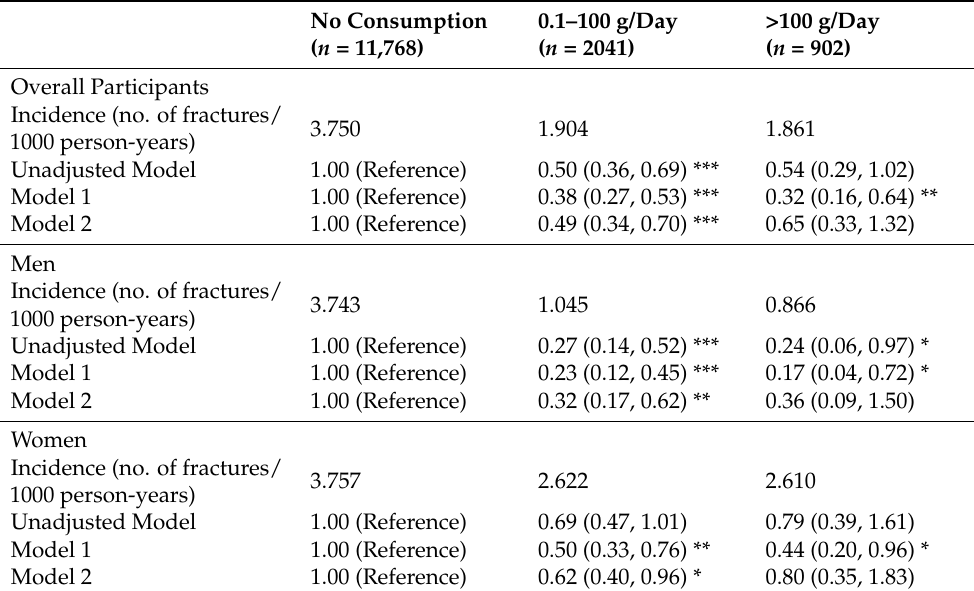
Table 2. Association between dairy product intake and the risk of